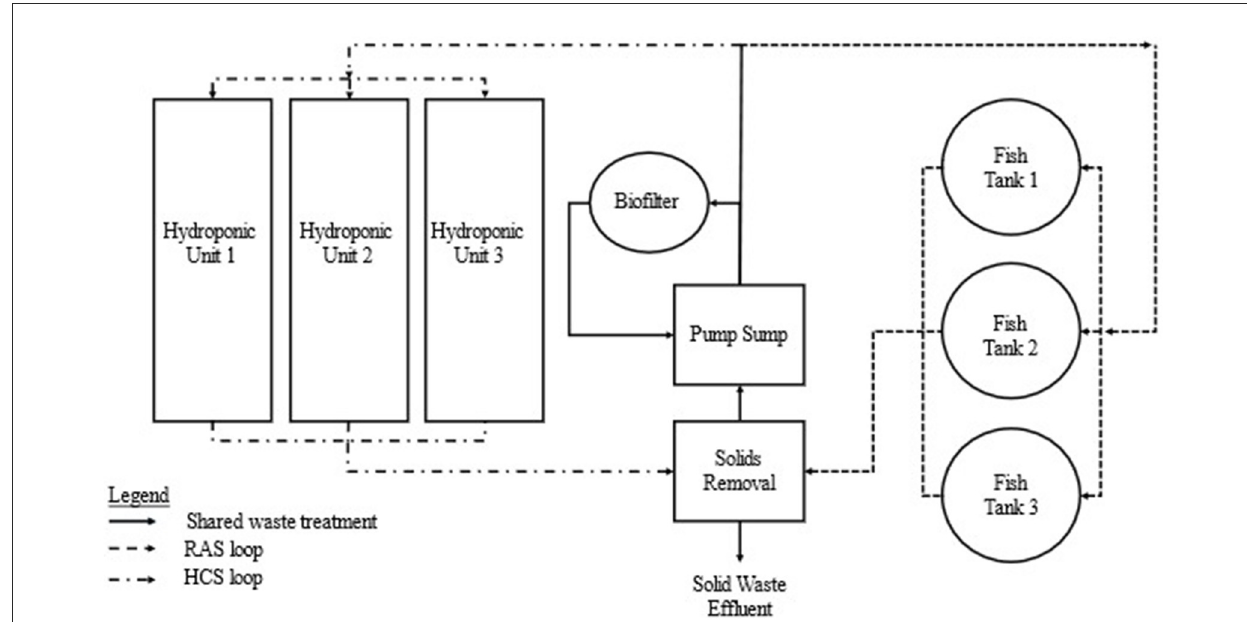
FIGURE2 Basic components of a parallel unit process design. Flow schematic demonstrating the parallel “loops” used for individual fish tanks and hydroponic units with a shared waste treatment process for solids removal and biological nutrient conversion. Flow rate and HRT to each unit can be optimized to RAS and HCS industry standards and units can be added (or removed) as they are operated independently without affecting existing operating practices.